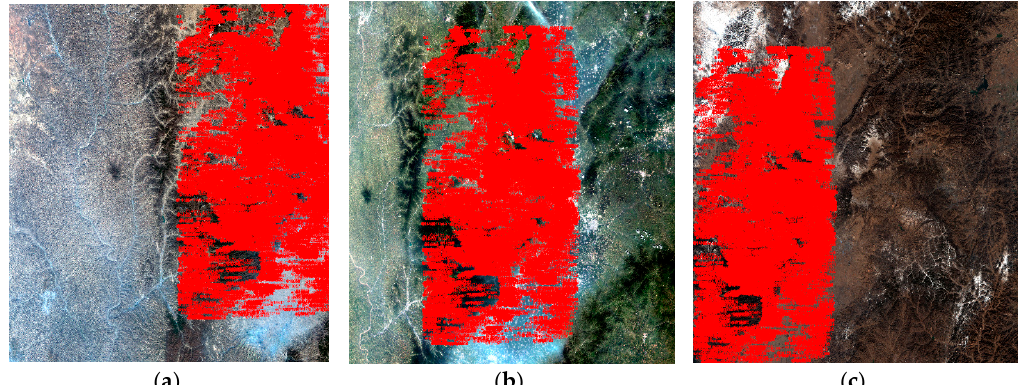
Figure 4. Corresponding points for distortion detection scenes selected from ( a ) scene 108244; ( b ) scene 068316; and ( c ) scene 125565.